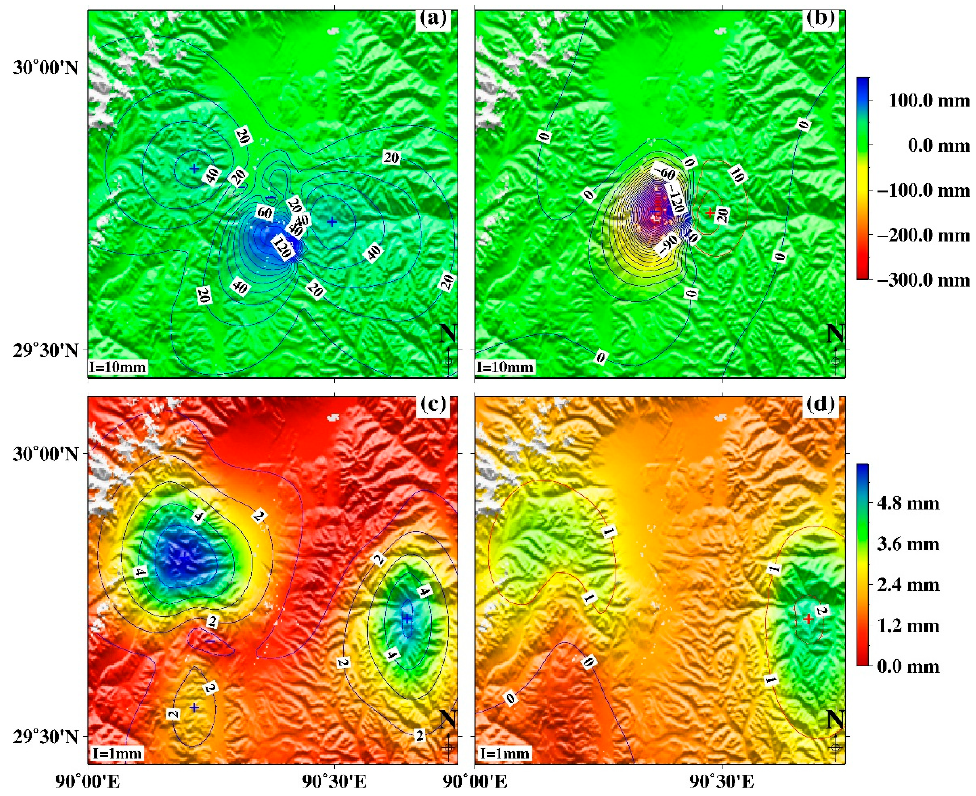
Figure 8. Contour map of coseismic surface displacements and differences between models with Young’s modulus of 9 ˆ 10 10 Pa and 4 ˆ 10 10 Pa. The contour interval is shown at the left bottom corner. ( a ) Horizontal coseismic surface displacement estimated from the model with Young’s modulus of 4 ˆ 10 10 Pa; ( b ) Differences in horizontal displacements between models with Young’s modulus of 9 ˆ 10 10 Pa and 4 ˆ 10 10 Pa; ( c ) Vertical coseismic surface displacement estimated from model with Young’s modulus of 4 ˆ 10 10 Pa; ( d ) Differences in vertical displacements between models with Young’s modulus of 9 ˆ 10 10 Pa and 4 ˆ 10 10